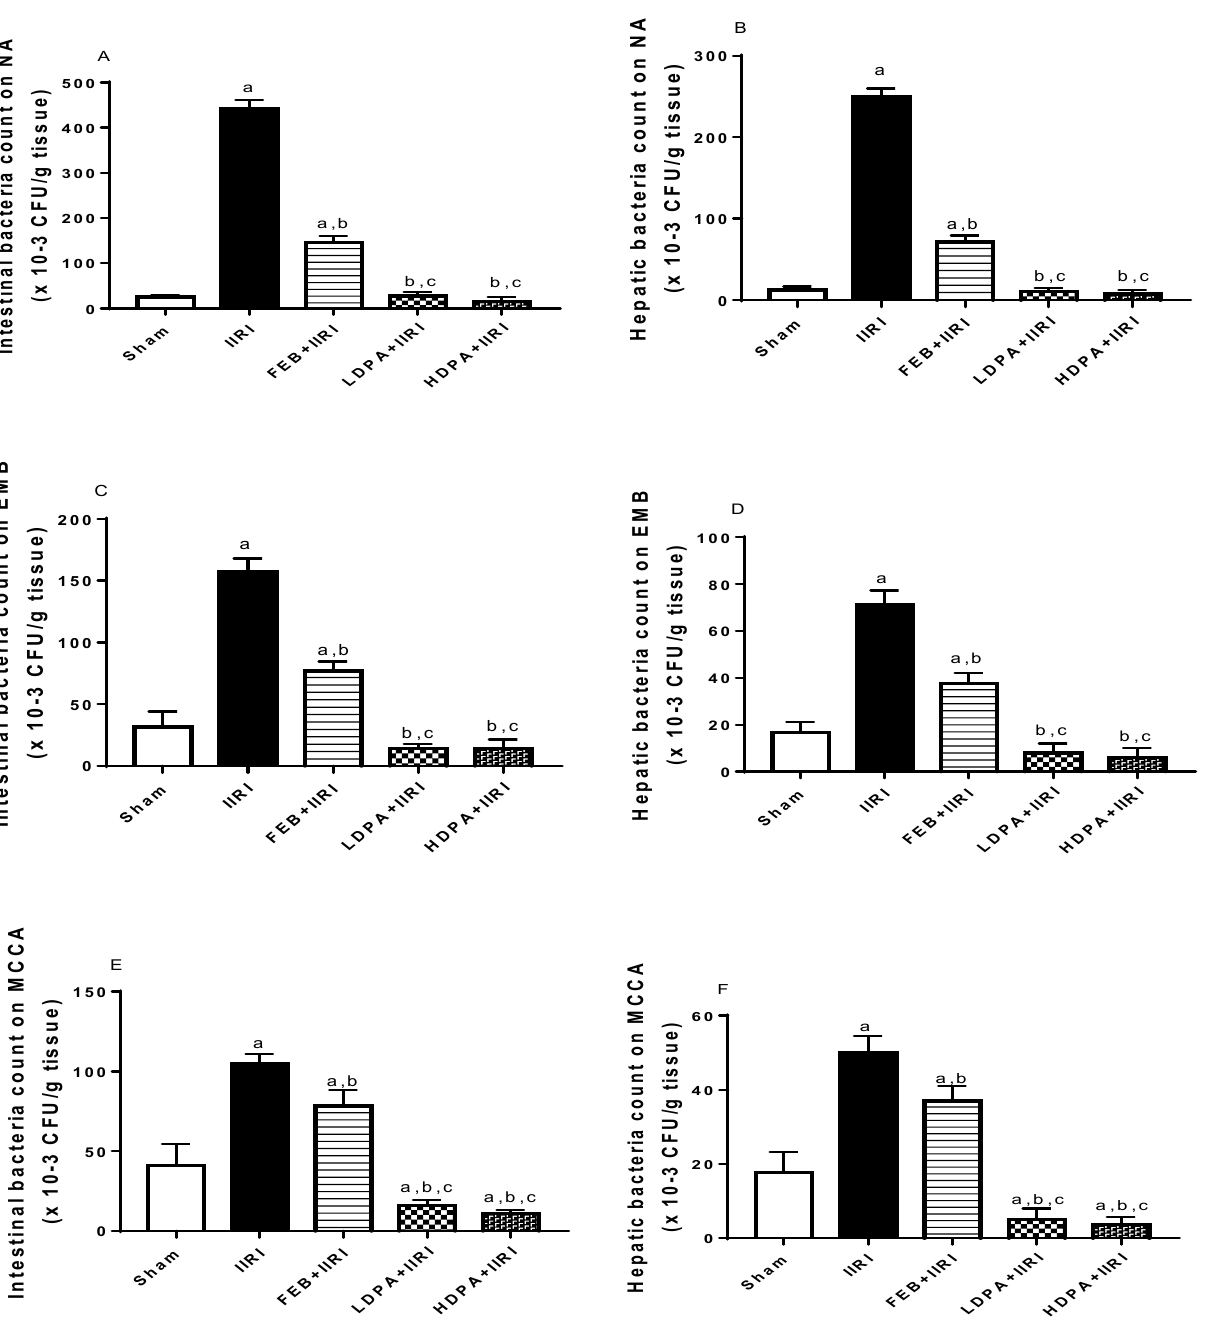
Figure 10. Effect of intestinal ischemia/reperfusion (I/R) and methanolic Phyllanthus amarus leaf extract on bacteria translocation. FEB, LDPA, and HDPA significantly reduced IIRI-induced increase in intestinal and hepatic bacteria count using nutrient agar (NA), ( A , B ), Eosin-Methylene Blue (EMB) ( C , D ), and Mac Conkey agar (MCCA) ( E , F ) media for colony counts. IIRI: intestinal ischemia/reperfusion injury, FEB: febuxostat, LDPA: low-dose Phyllanthus amarus , HDPA: high-dose Phyllanthus amarus , a p < 0.05 versus sham, b p < 0.05 versus IIRI, c p < 0.05 versus FEB + IIRI. Values represent the mean for ten replicates ± the standard deviation. IR promotes reactive oxygen species (ROS) and pro-inflammatory cytokine genera- tion, which in turn translocate Bax from the cytosol into the mitochondrial outer mem- brane, where it becomes activated by binding with BH3-only proteins. Activated Bax oli- gomerizes to form pores in the mitochondrial outer membrane and triggers the release of